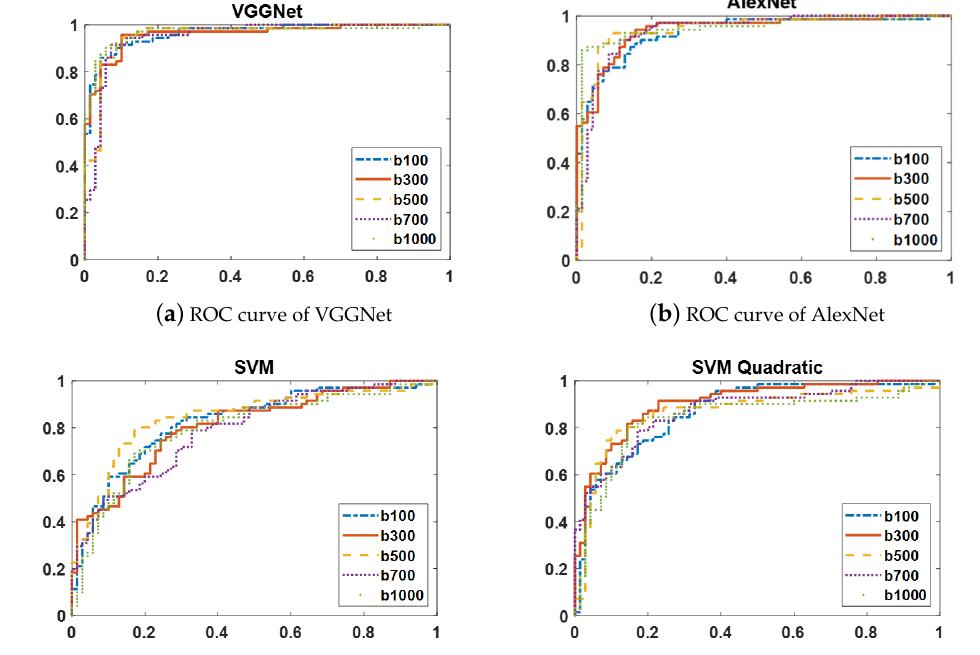
( c ) ROC curve of support vector machine (SVM) with ( d ) ROC curve of SVM with quadratic kernel linear kernel Figure 5. ROC curves at five b-values(100, 300, 500, 700, and 1000 s/mm 2 ) of four different classifiers: ( a ) VGGNet, ( b ) AlexNet, ( c ) SVM with linear kernel, and ( d ) SVM with quadratic kernel. As these figures show, CNN-based models (VGGNet and AlexNet) result in higher AUCs than the two variants of SVMs with linear and quadratic kernels at the distinct